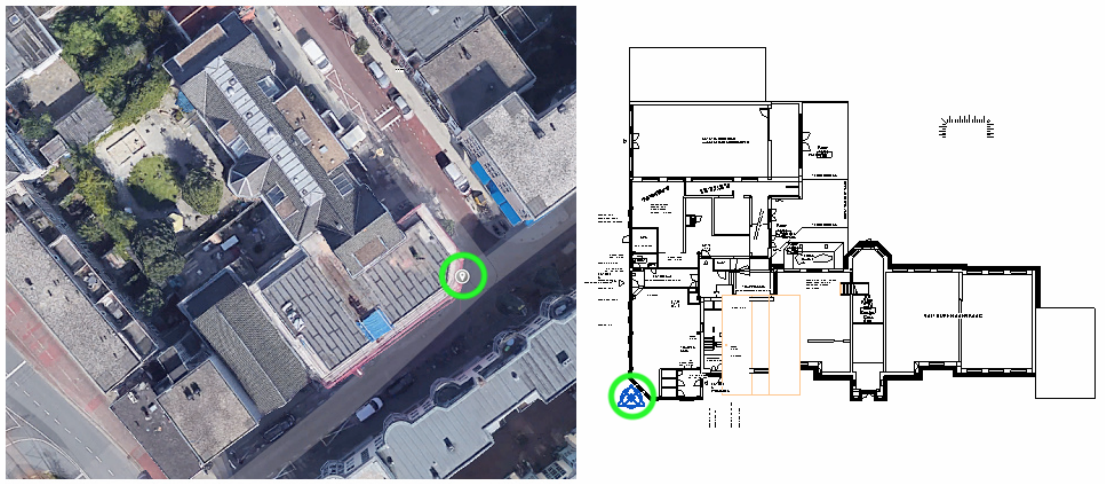
Figure 17. A screenshot from Google Maps is used to identify the orientation of the building with respect to the true North. The green circles indicate the project base and survey points.